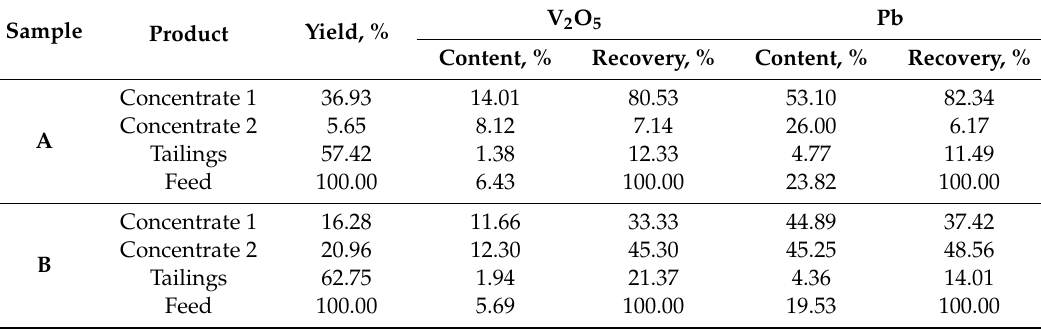
Table 5. Results of gravity testing of high-grade sample on the shaking